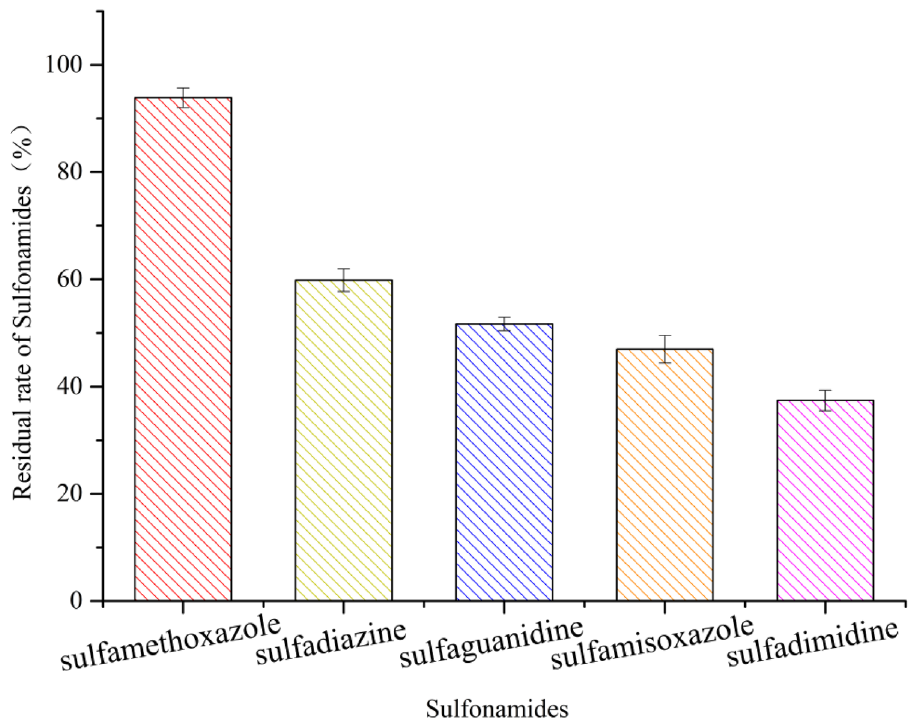
Figure 7. Degradation kinetics of various sulfonamides by S. mizutaii LLE5. The symbols represent averages of triplicate experiments and the error bars indicate their corresponding standard